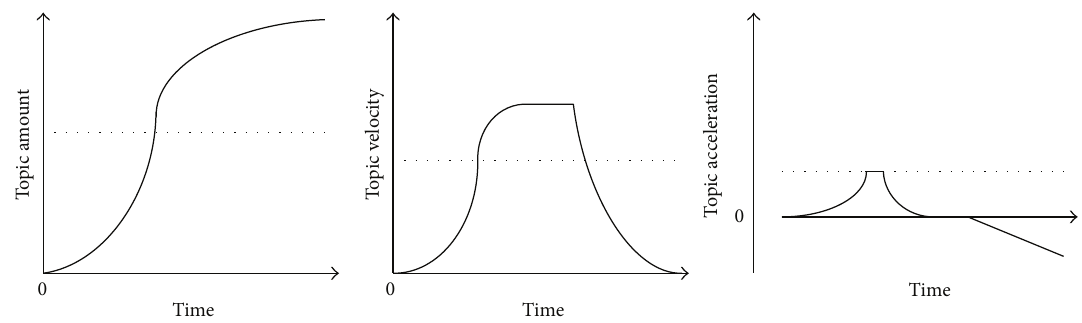
Figure 1: A hot topic with the topic amount, velocity, and acceleration.